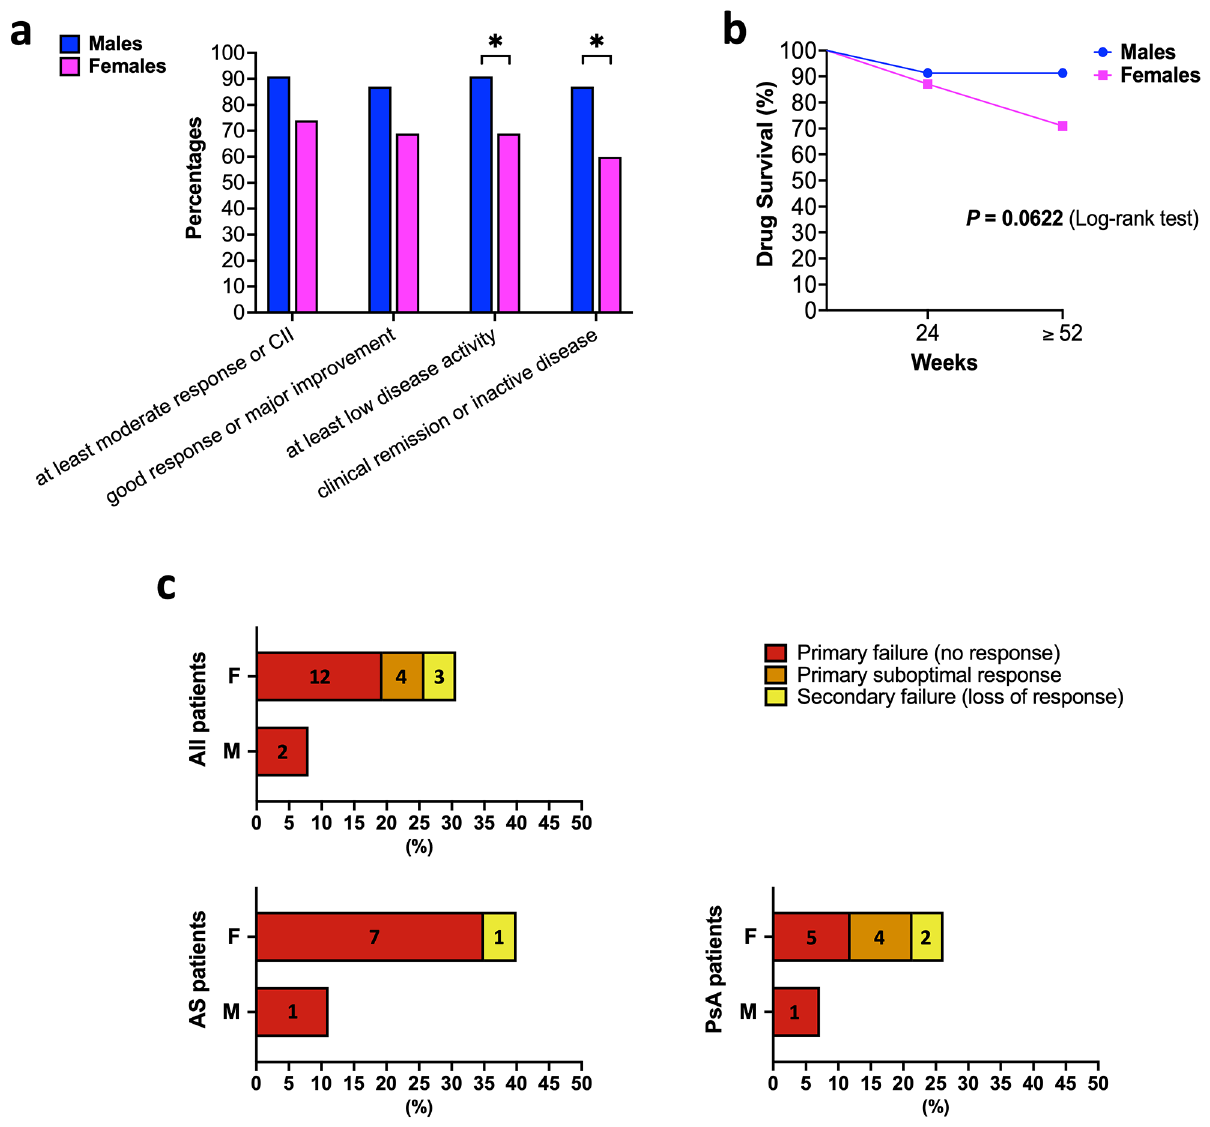
Fig. 3 Impact of gender on response to secukinumab. a) Percentages of male and female patients with AS or PsA achieving different outcomes at 52 weeks of treatment. CII, clinically important improvement. * P < 0.05 (males vs. females). b) Kaplan-Meier drug survival curves of male and female patients during one year of follow-up. c) Percentages (and numbers) of male and female patients who experienced poor outcomes during follow-up (i.e., primary and secondary failures or suboptimal responses accounting for subsequent drug discontinuation), in the whole cohort and separately in the AS and PsA